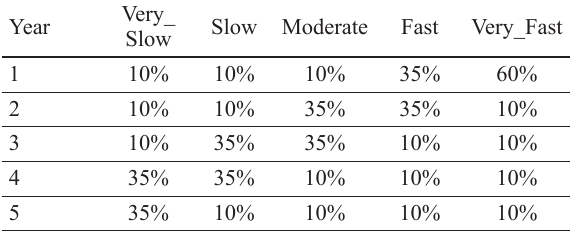
Table 4. Sales rate for each period